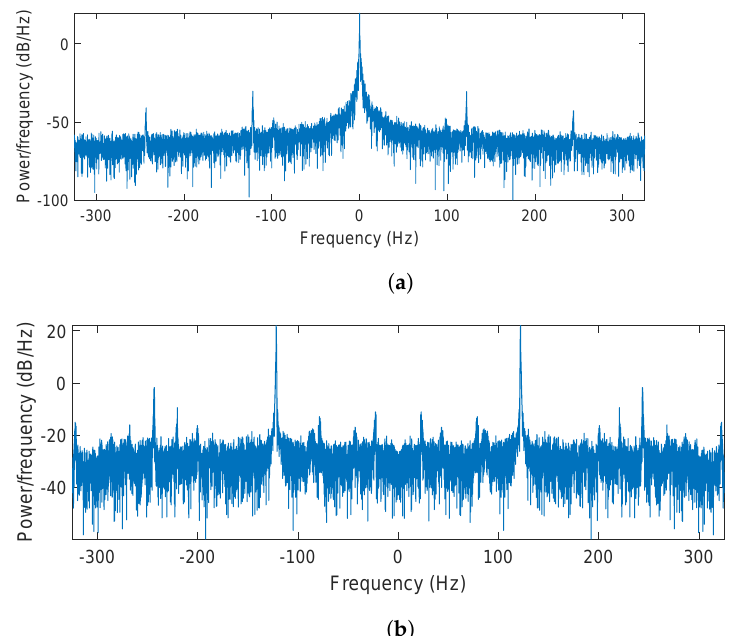
Figure 3. ( a ) Spectral density of synchronized baseband signal. ( b ) Spectral density of IMU